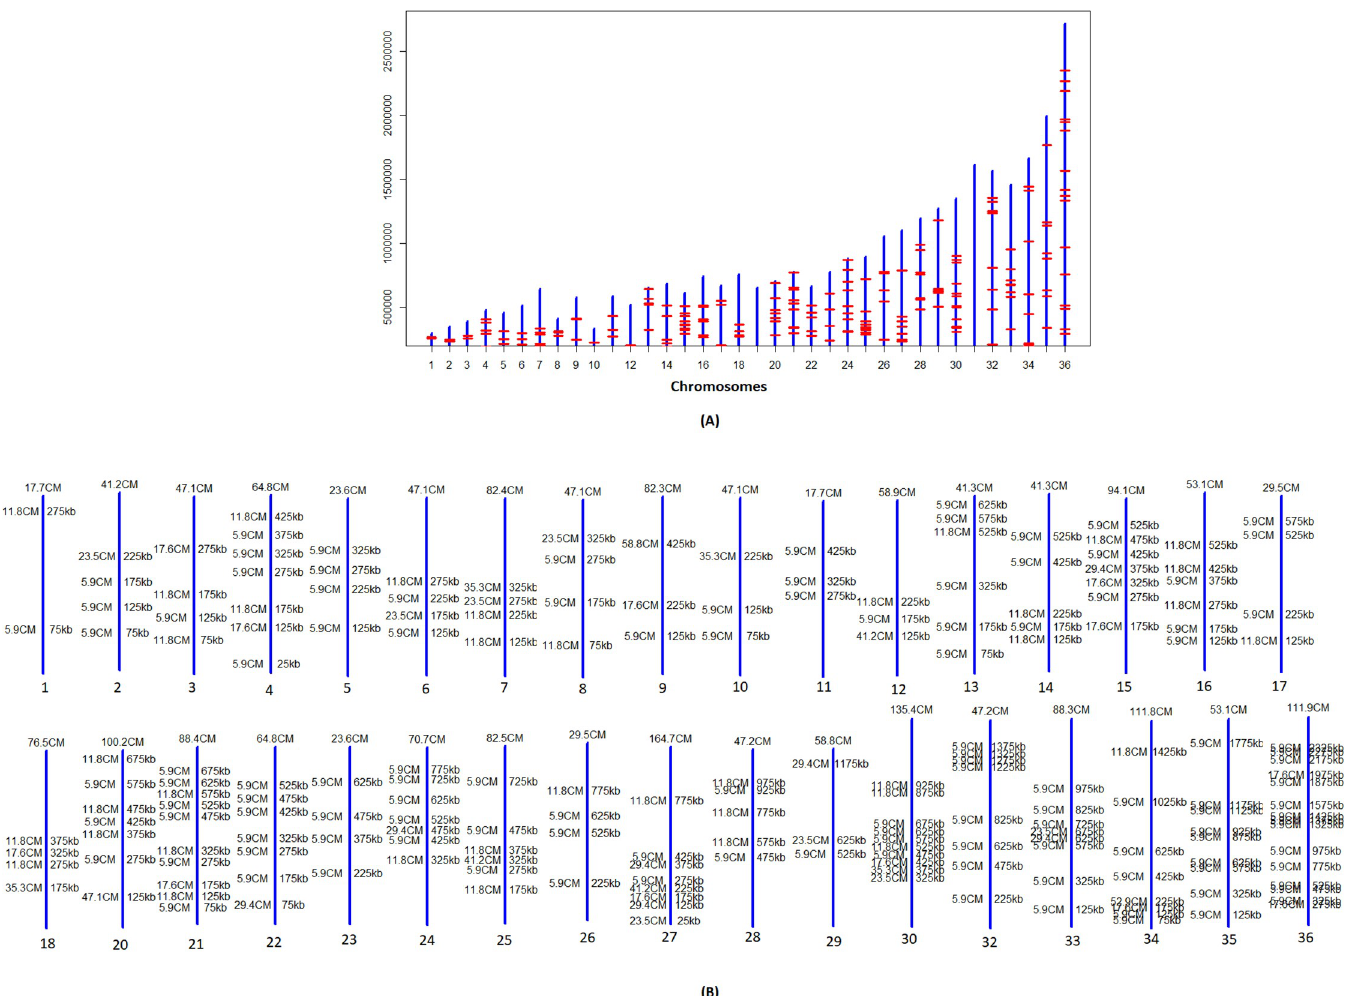
Fig 6. Physical and genetic maps of L . tropica hybrids. A) Physical map showing the collective recombination breakpoints across the genome observed in 17 L . tropica hybrids generated between LtKub/SAT and Lt L747/HYG or LtMA37/NEO. The break points, represented by the red horizontal bars, are plotted by chromosome which are represented by the blue vertical bars that are roughly scaled to the chromosome lengths. Although the recombinations were distributed across the genome, there were apparent hotspots, defined as more than 2 recombinations in a 50kb window (highlighted by circles), and cold spots, including whole chromosomes, where few or no recombinations were found. B) A genetic map was constructed based on the crossovers observed in the 17 L . tropica hybrids. Centimorgan distances were calculated in windows of 20kb across the genome by counting total recombinations across all samples and dividing by total sample size. The total centimorgan distances for each chromosome are indicated at the top of the chromosome. The chromosome lengths are not true to scale, but are arranged from small to large as shown in Fig 6B. The total genome-wide map size is 2091.4 cM with an average of 61.5 cM/chromosome.